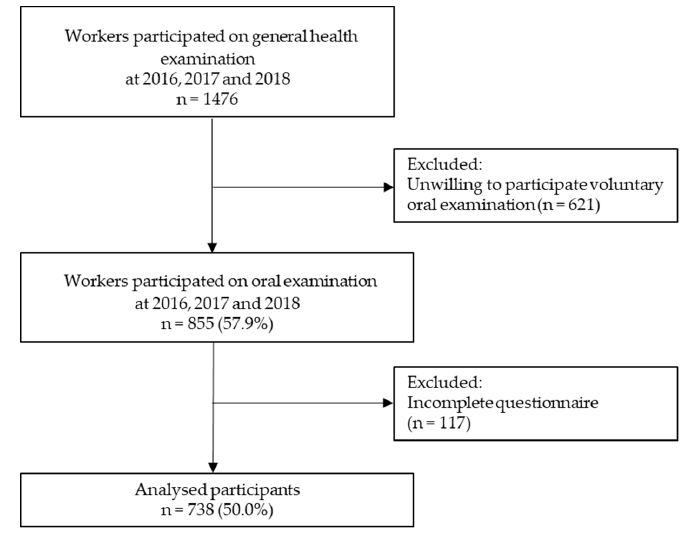
Figure 1. Flowchart of the enrollment procedure. Table 1. Characteristics of all